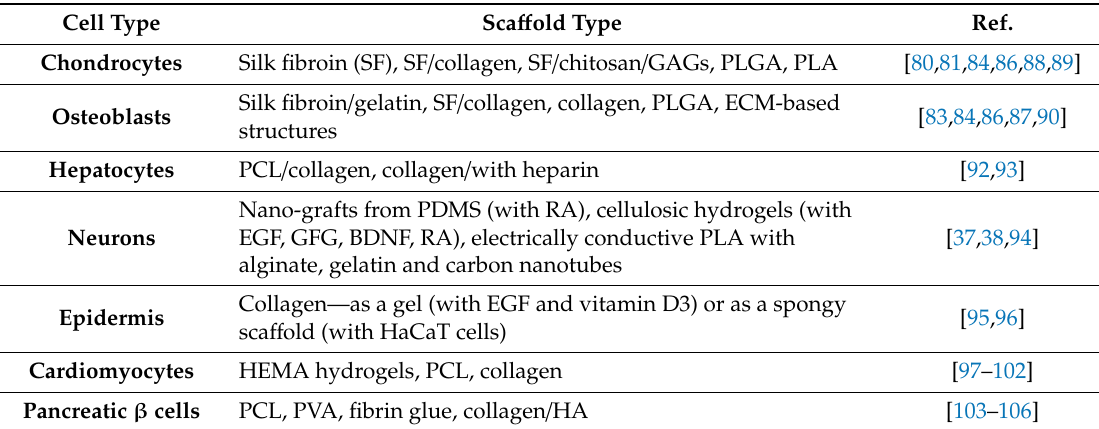
Table 2. Enhancing MSC di ff erentiation with sca ff old